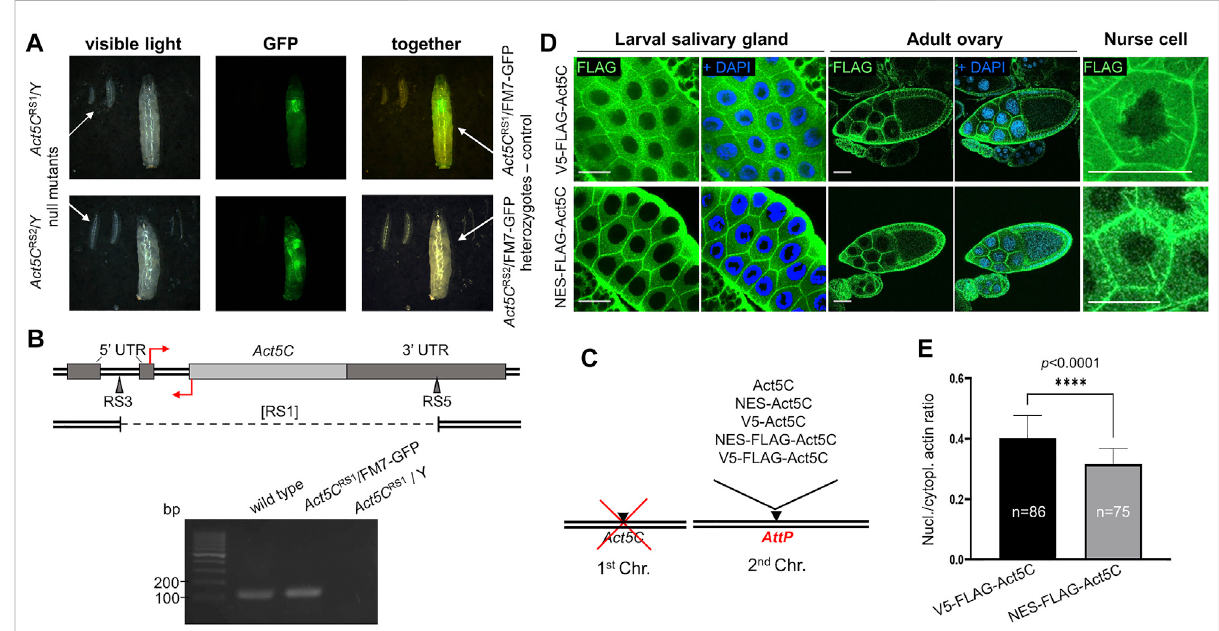
FIGURE 1 Rationale of the experimental system used to investigate nuclear actin. (A) Both Act5C null alleles (RS1 and RS2) cause 100% developmental arrest inthe fi rstlarval stageinhomo-andhemizygous formas comparedtotheirheterozygote,third-instarfemalesiblingsofthesameage marked with a GFP expressing balancer chromosome (FM7-GFP). (B) Genomic organization of Drosophila Act5C gene. Protein coding (light gray rectangle) and noncoding (dark grey rectangles) exons are shown. The insertion sites for the RS3 and RS5 transposons used to generate a deletion are marked with triangles. Deleted segment in the [RS1] allele is represented by dashed line under the map. Primers for RT-PCR are indicated by red arrows.Forwardprimerbindinginthe3 ′ UTRislocatedabove;reverseprimerbindingbehindthetranslationSTARTsiteislocatedbelowtheDNA.Gel (below) shows RT-PCR products of 136 bp using the primers shown above. (C) The modular genetic system used in this study consists of the null mutation of Act5C on the fi rst chromosome, and various transgenes expressing different forms of actin under the regulation of Act5C inserted into the same genomic position on an autosome. (D) Immunostaining of larval salivary gland cells and adult ovaries for actin (V5-FLAG-Act5C) and NES- tagged actin (NES-FLAG-Act5C) proteins (green) expressed from transgenes. Nuclei are visualized by DAPI staining (blue). Scale bar, 50 μ m. (E) Quanti fi cation of the immunostaining of salivary glands in (D) . Unpaired t- test was used for statistical analysis, **** p < 0.0001. Error bars represent standard deviation. “ n ” is the number of cells